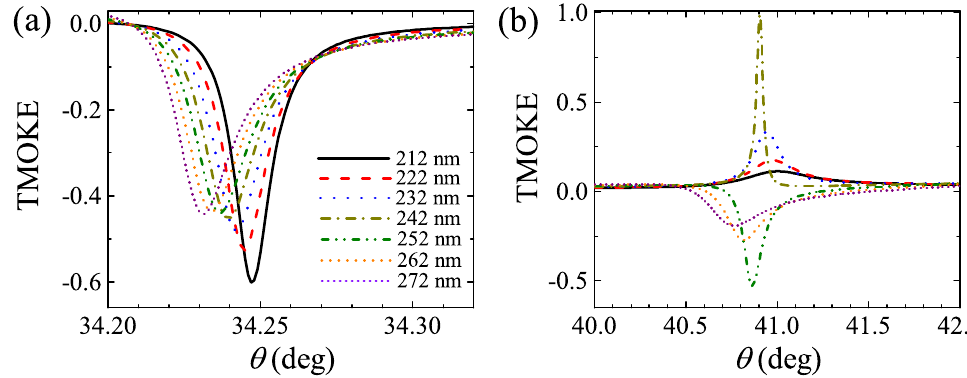
Figure 6. Numerical analysis of TMOKE associated with the ( a ) BPP 0 and ( b ) BPP 1 resonances from the vertical dotted line B in Figure